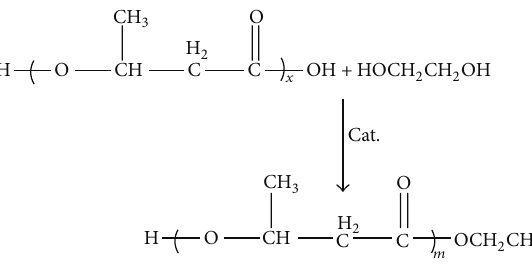
Scheme 1: Synthesis of PHB